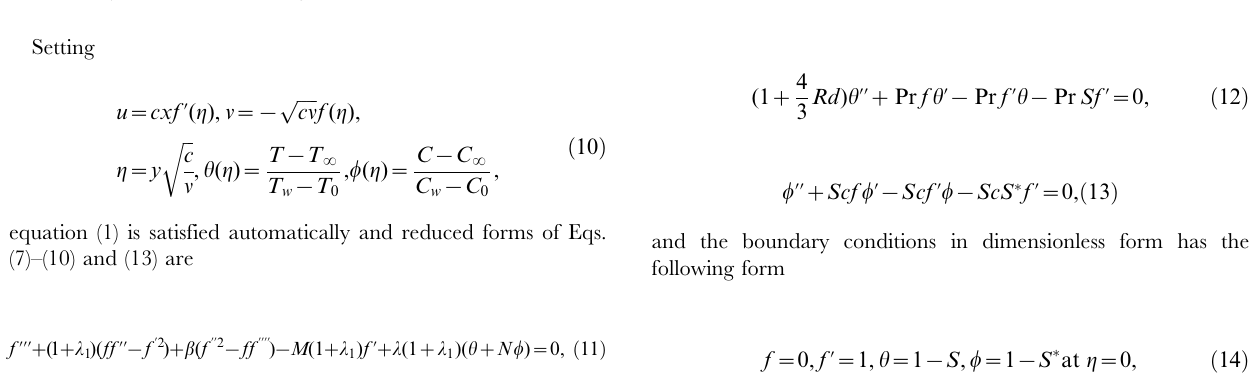
Figure 4. Influence of b on the velocity profile f ’ ( g ) when M ~ 0 : 6, Rd ~ 0 : 4, l 1 ~ 0 : 5, l ~ 0 : 3 ~ N , Pr ~ 1 : 2, S ~ 0 : 2 ~ S (cid:2) and Sc ~ 1 : 0 :